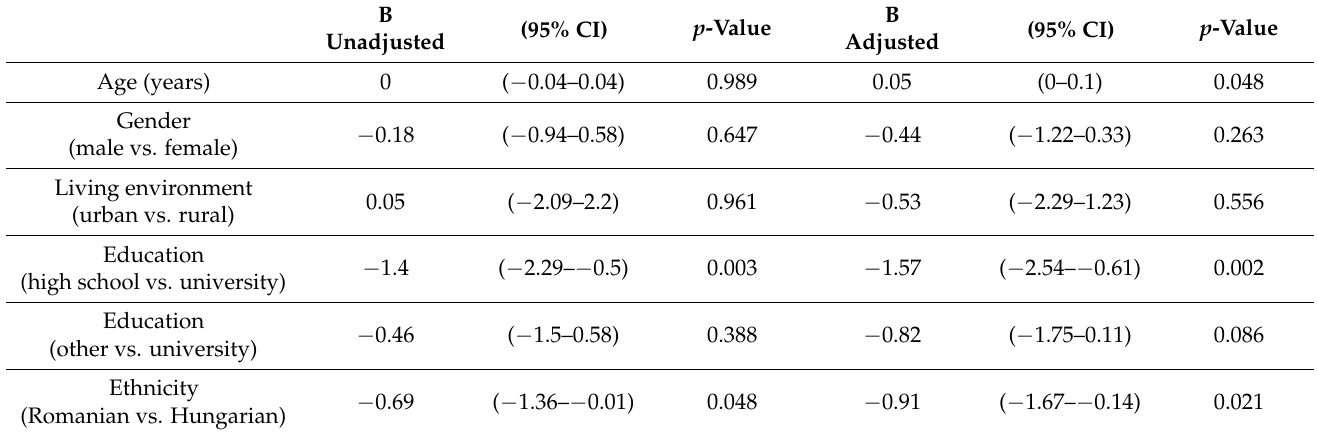
Table 4. Simple and multiple linear regression models predicting extraversion score differences (pre-COVID-19 versus COVID-19 period).